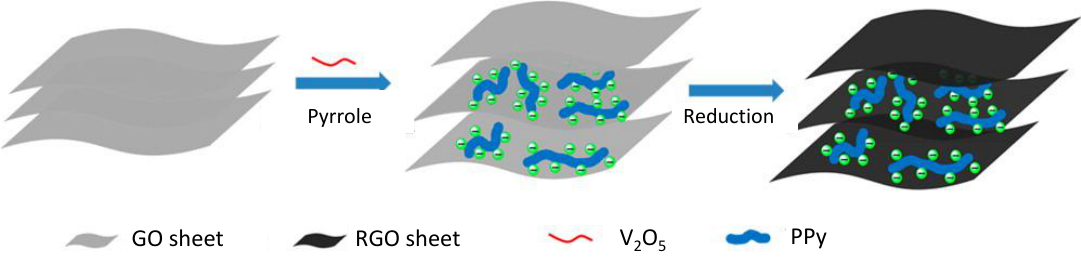
Figure 16. Scheme showing the synthetic route of PPy/RGO composites. With permission from [110]; Copyright 2014, American Chemical